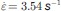
Comparison of the reduced relaxation function (Equation 5) from measurement of different skin samples.The solid line shows median data from work presented here on mouse hindlimb skin fitted to the one-term model, in the first experiment with median strain rate ε˙=3.54s−1. The dotted-dash line gives a measurement from pig dorsal skin [11]. The dashed and dotted lines are both from rat skin, but the dashed line function is attributable only to collagen elements in the skin while the dotted function is only elastin elements [4]. Note that the skin in compression relaxes more than skin in tension.